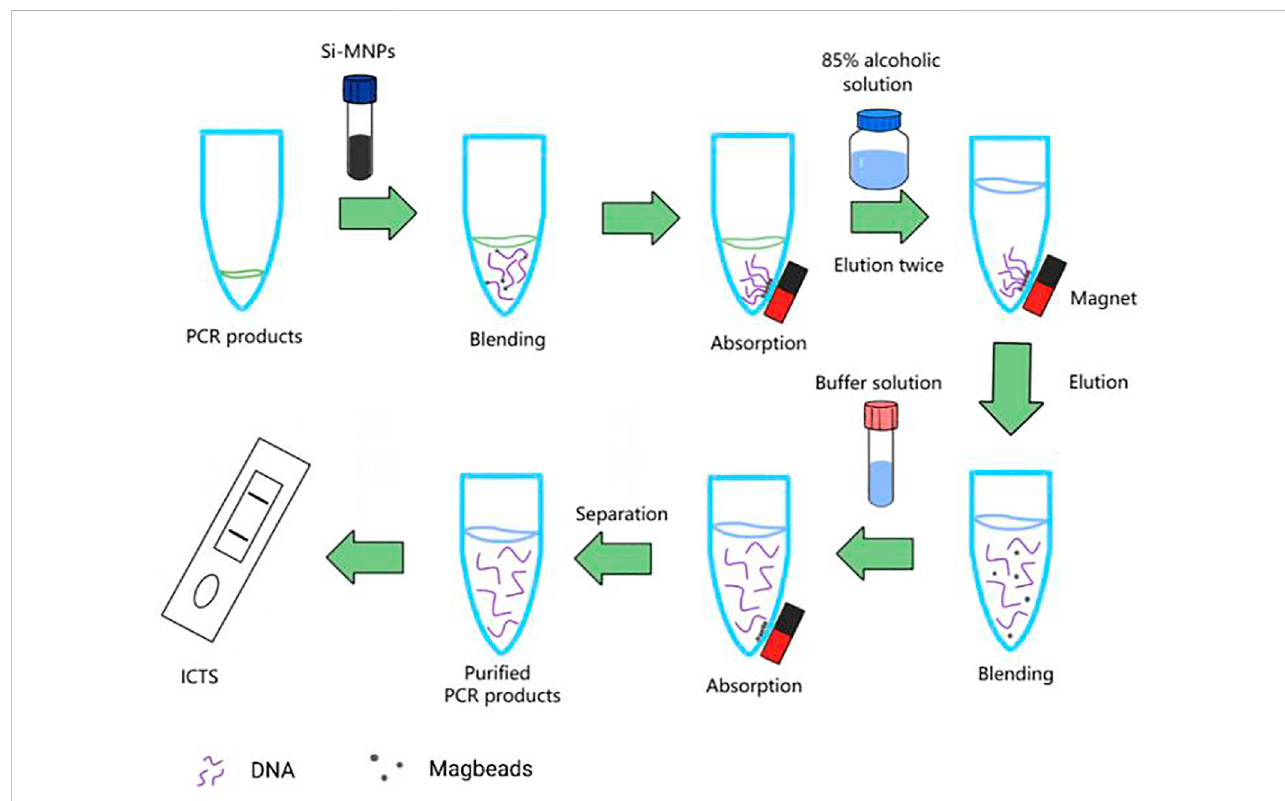
FIGURE 2 The illustration of Si-MNPs puri fi ed SEA/PCR